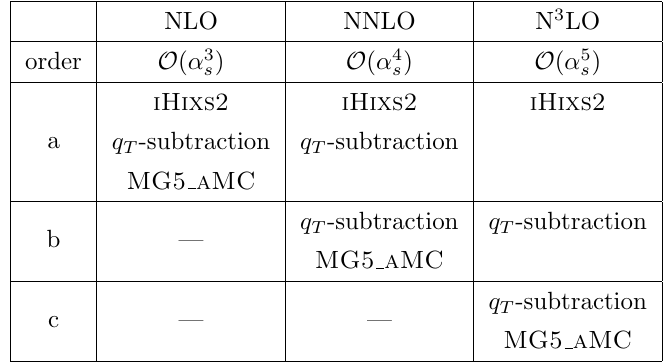
Figure 8 . The comparisons of the NLO class- c cross sections from the q T -subtraction method (error p bars) and MG5 aMC (red band) at s = 13 TeV LHC. The error bars and the band denotes the Monte Carlo integration errors.